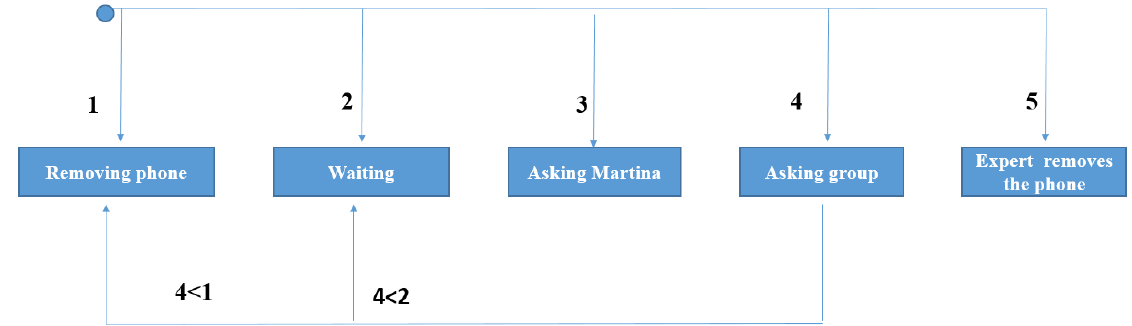
Figure A3. Situation 3—Poor connection. Note. 1 = execution; 2 = doing nothing; 3 and 4 = communication; 5 = giving orders.